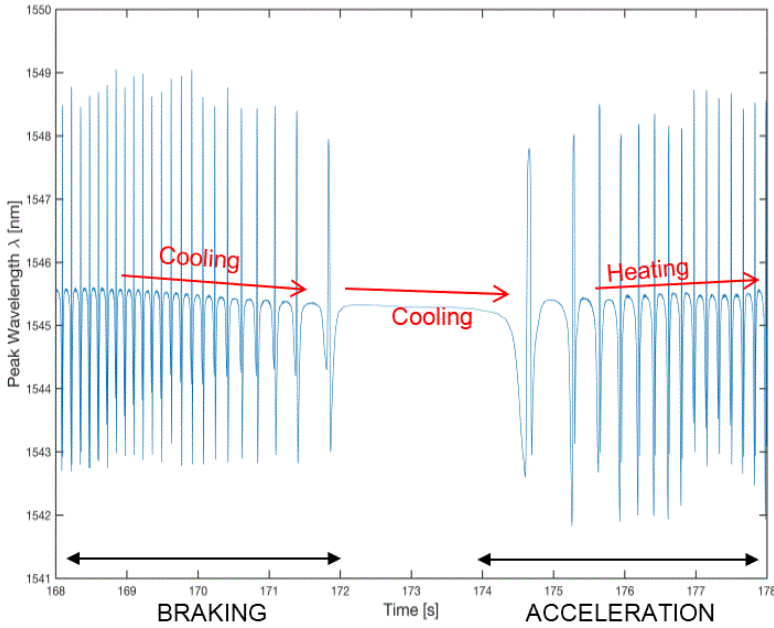
Figure 22. Detail of Figure 21 between 168 s and 178 s with a stop-start sequence between 172 s and 174.5 s.